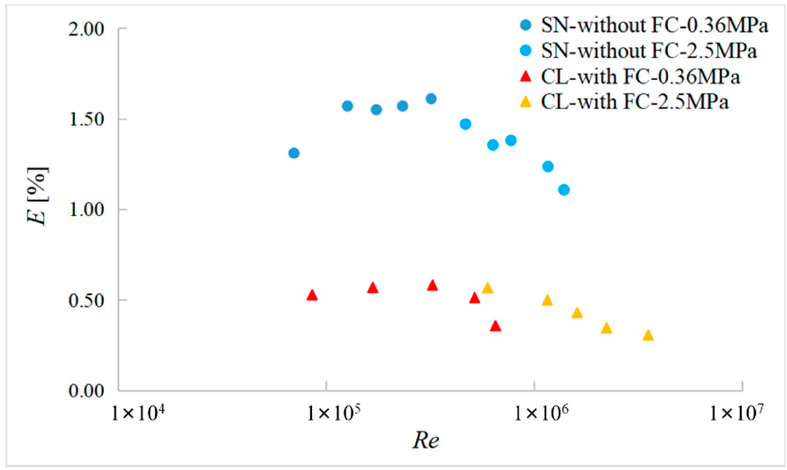
Figure 7. The difference between two devices at different pressures.